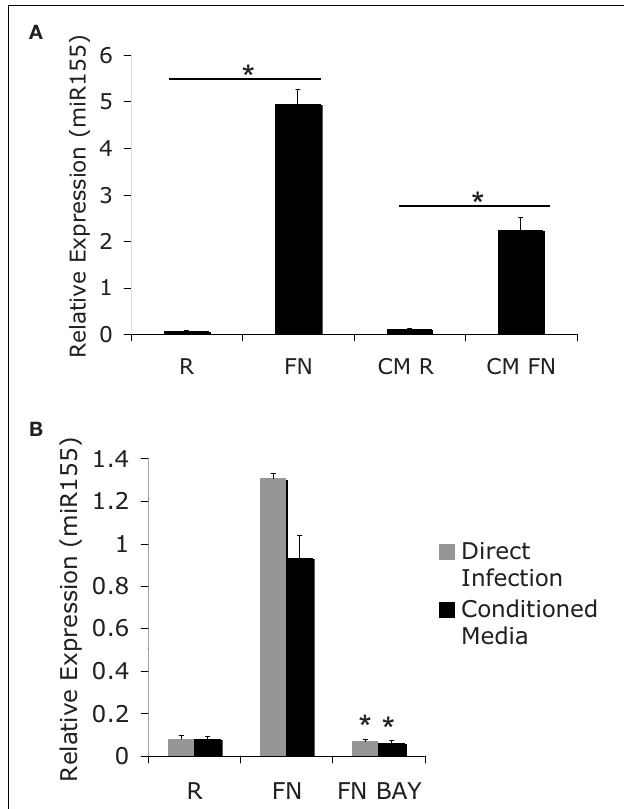
FIGURE 2 | MiR-155 induction can be mediated indirectly though secreted factors. (A) PBM were infected with FN at an MOI of 50 for 24h. Media from infected cells was sterile filtered to remove bacteria and RNA was isolated from the cells (R and Fn). New PBM were cultured in the conditioned media for 24h (CM R and CM FN) followed by RNA isolation. Mature miR-155 expression was assayed by qRT-PCR. (B) PBM were infected for 24h, then the media from the infected cells was sterile filtered to generate conditioned media. New PBM were infected with F.n. at an MOI of 50 for 6h or treated with conditioned media for 6h in the presence of BAY-7085-11 (5 μ M) or DMSO control. MiR-155 expression was assayed by qRT-PCR.These data are representative of at least three independent experiments. *Designates a p value < 0.05.